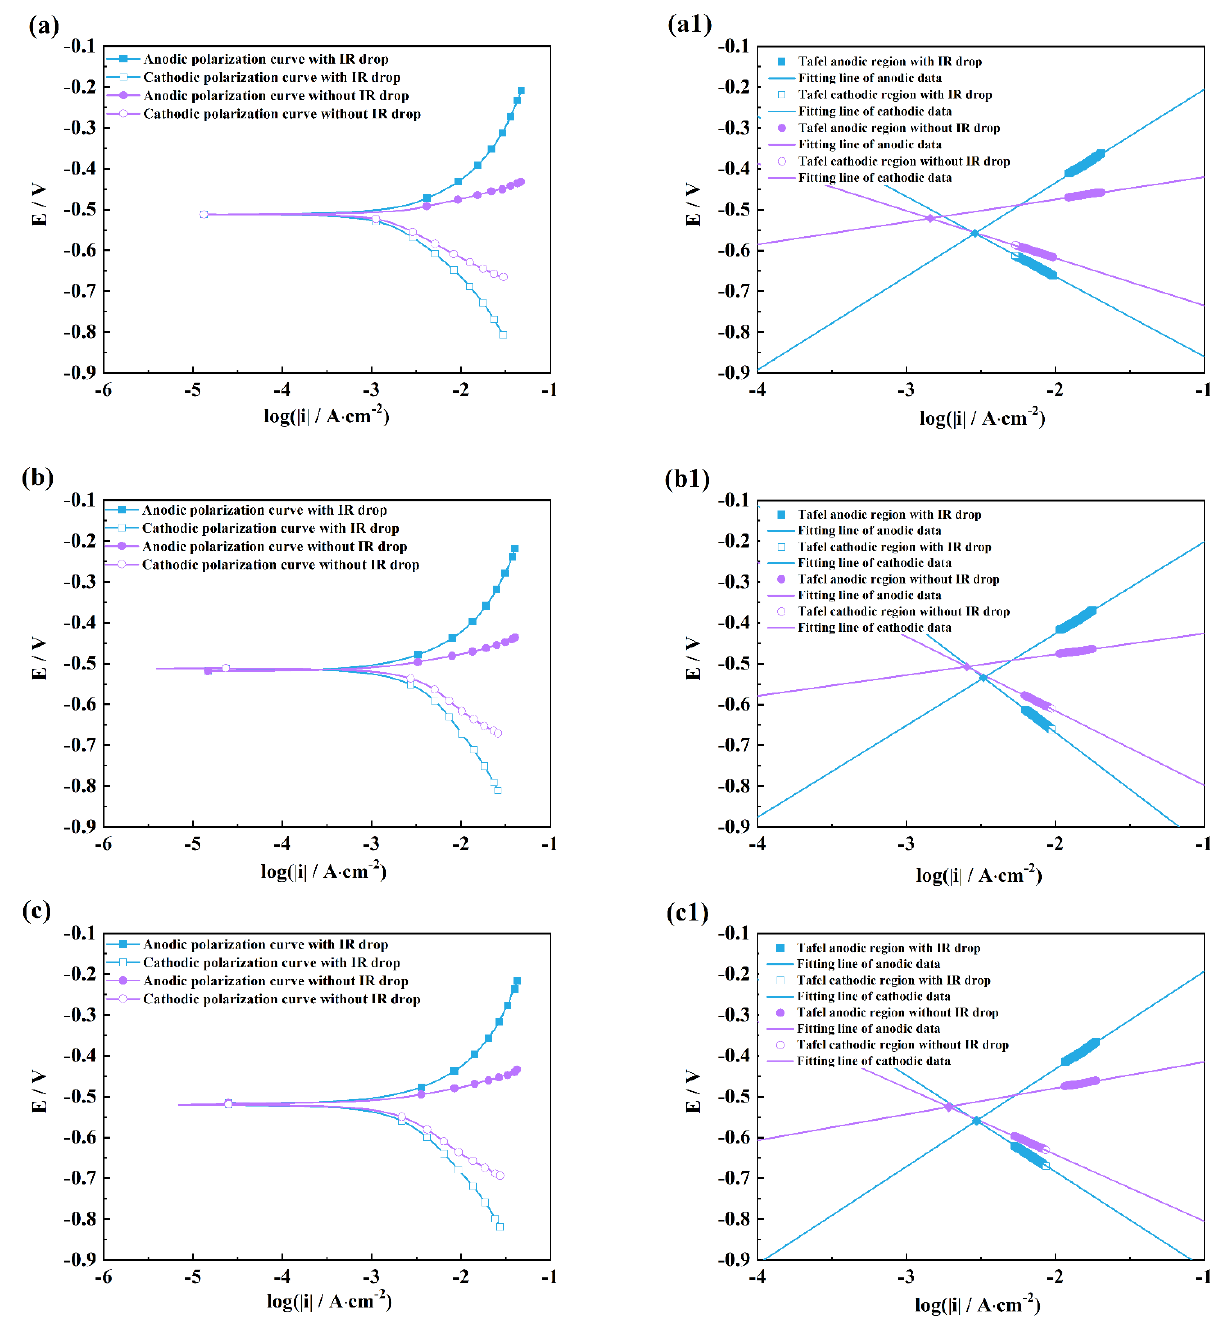
Figure 4. Comparison of polarization curves with and without an IR drop of M1 ( a ), M2 ( b ), M3 ( c ), and linear fitting plots of the Tafel regions of M1 ( a1 ), M2 ( b1 ), M3 ( c1 ) in HCl solutions after 2h exposure.